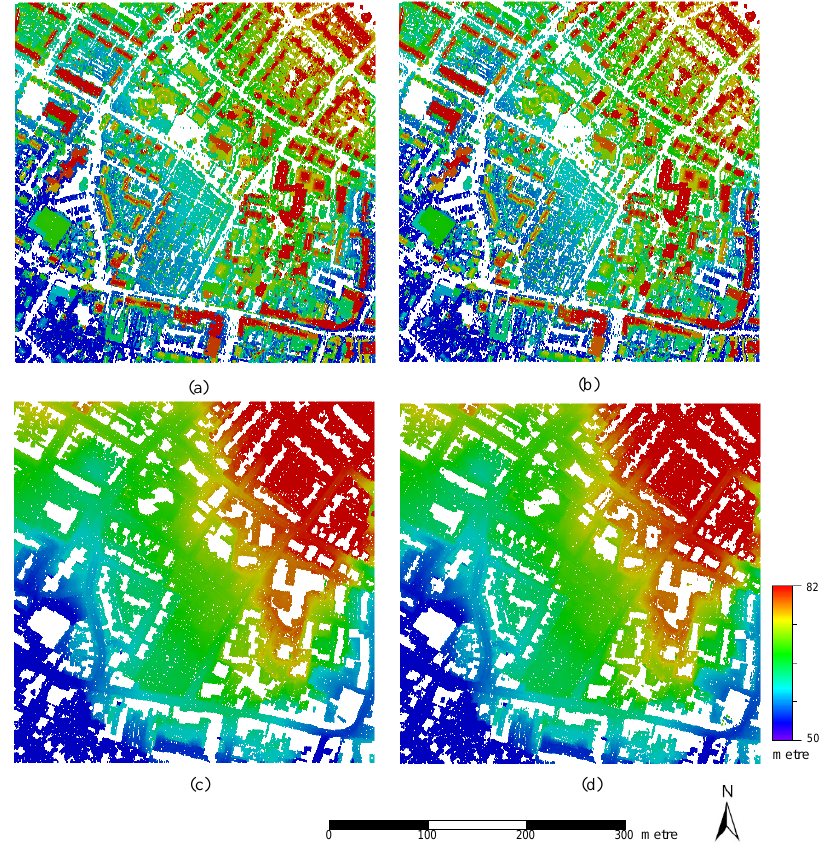
Figure 18. Results of the proposed method filtering AHN Test Site 2: ( a ) true non-ground points; ( b ) non-ground points derived by this filter; ( c ) true ground points; and ( d ) ground points derived by this filter.